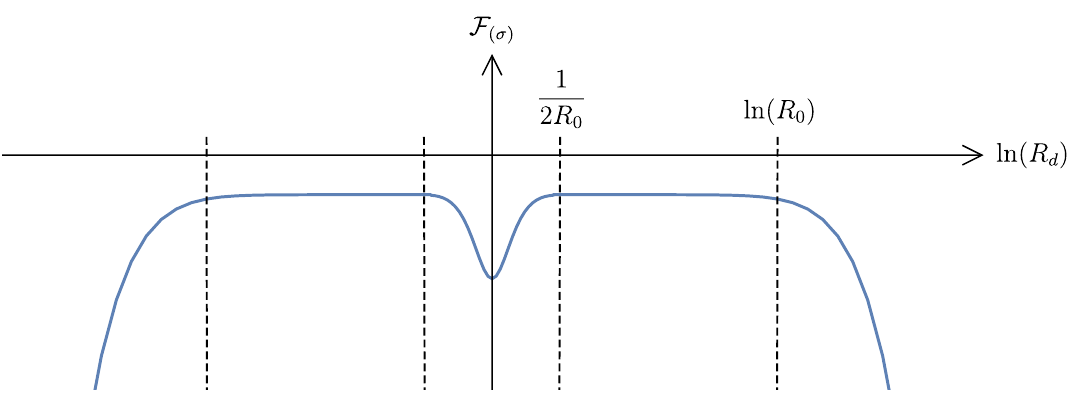
Figure 1 . Qualitative shape of the free energy density F ~ n F (cid:0) ~ n B (cid:20) 0, or for low enough M well of size max(1 =R 0 ; 1 =R 9 ). On both of its sides, plateaus extend until (cid:6) min(ln R 0 ; ln R 9 ). The latter are followed/preceded by exponential falls if n F (cid:0) n B (cid:20) 0, or for low enough M n F (cid:0) n B > 0. The exponential behavior is increasing for large enough M